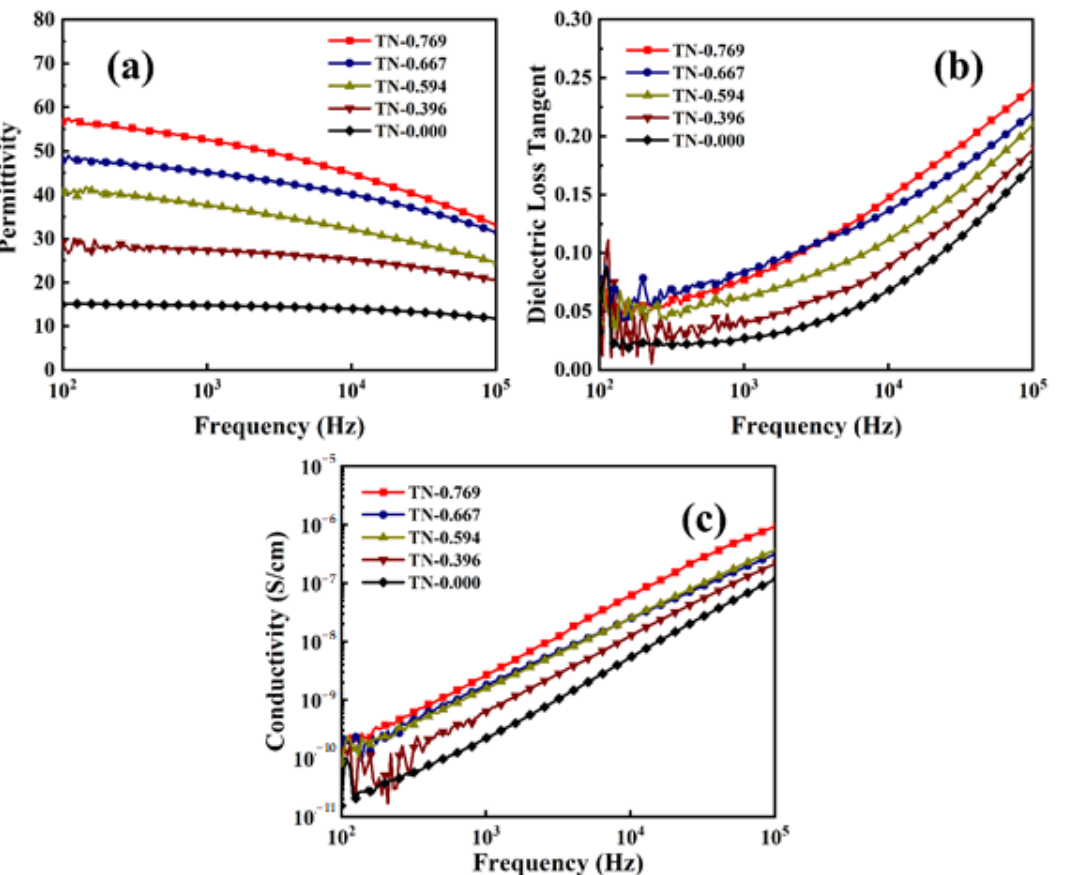
Figure 8. Frequency-dependent ( a ) permittivity, ( b ) dielectric loss and ( c ) electric conductivity of the composite TN-0.769, TN-0.667, TN-0.594, TN-0.396 and TN-0.000.